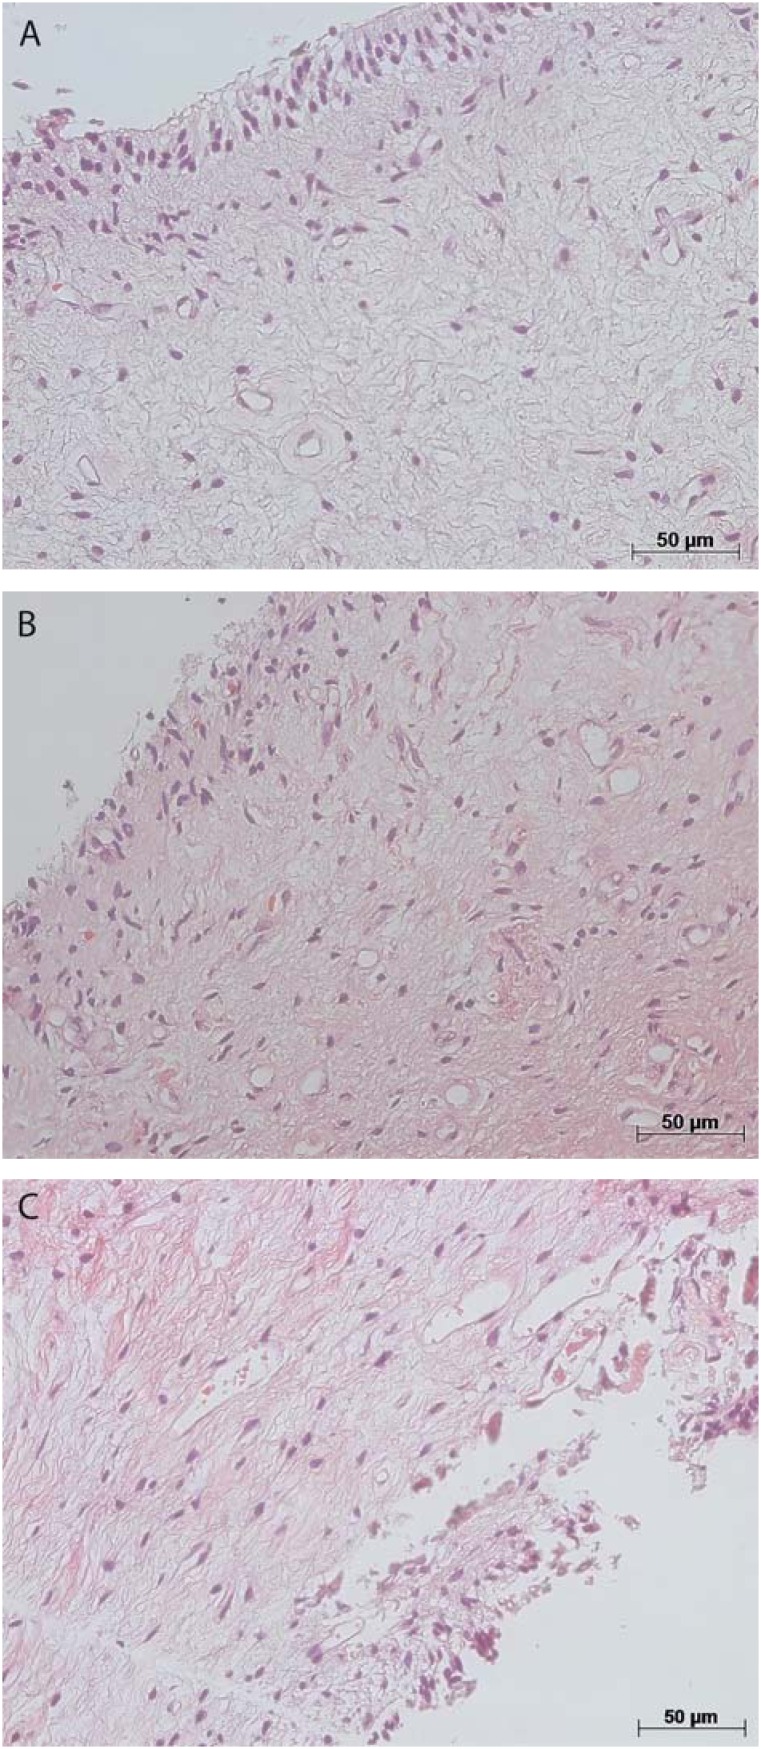
Photomicroscopy illustrating preserved collagen (score 0) and well-organized pulp tissue (score 0) in control group (A); preserved collagen (score 0) and disorganized pulp tissue (score 1) in at-home bleaching group (B); and degraded collagen (score 1) and disorganized pulp tissue (score 2) in in-office bleaching group (C). Hematoxylin & eosin staining, original magnifications 200X; A-C